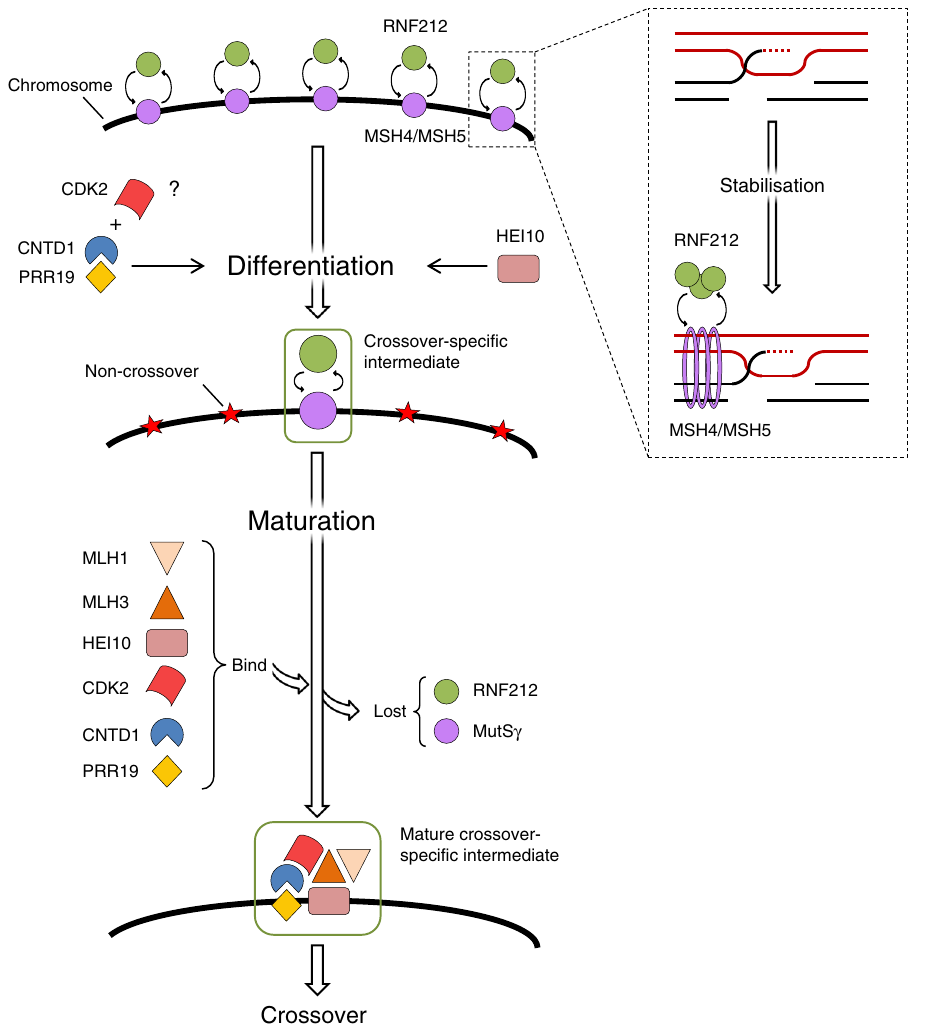
Fig. 8 Summary and model of PRR19 – CNTD1 functions in crossover formation. Block arrows represent progression in recombination, line arrows represent promotion. Inset shows recombination intermediates, where red and black lines represent the single-DNA strands of homologous DNA duplexes, and the dotted red line marks repair DNA synthesis. Whereas four chromatids are present at this stage, only two are shown for the sake of simplicity. A positive feedback between MutS γ (MSH4/MSH5 sliding clamp complex) and RNF212 stabilises DNA-strand-invasion intermediates that serve as